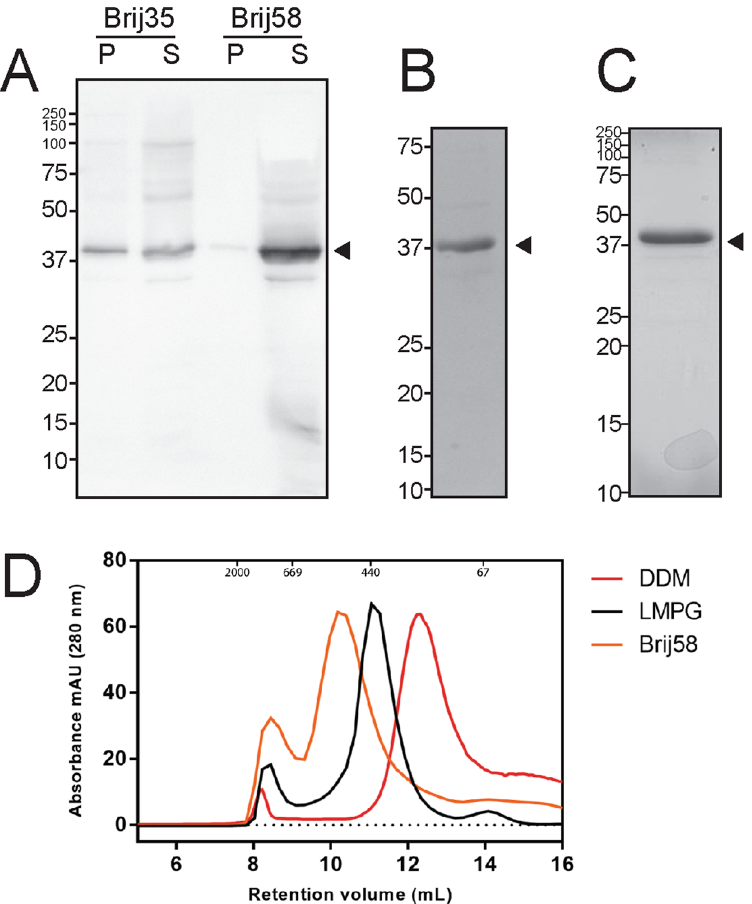
Figure 2. Expression and purification of malE-enNTS 1 . malE-en2NTS 1 could be expressed in either D-CFPS or P-CFPS mode. ( A ) Anti-His immunoblot highlighting better solubility of malE-en2NTS 1 in Brij58 compared with Brij35 during D-CFPS mode with near complete solubilisation in the soluble (S) fraction and very little seen in the insoluble pellet (P). ( B and C ) Coomassie stained SDS-PAGE of Ni-IMAC purified malE-en2NTS 1 obtained from D-CFPS and P-CFPS modes respectively. Arrows indicate malE-en2NTS 1 . ( D ) Size-exclusion profiles for malE-en2NTS 1 in three solubilising detergents, DDM, LMPG and